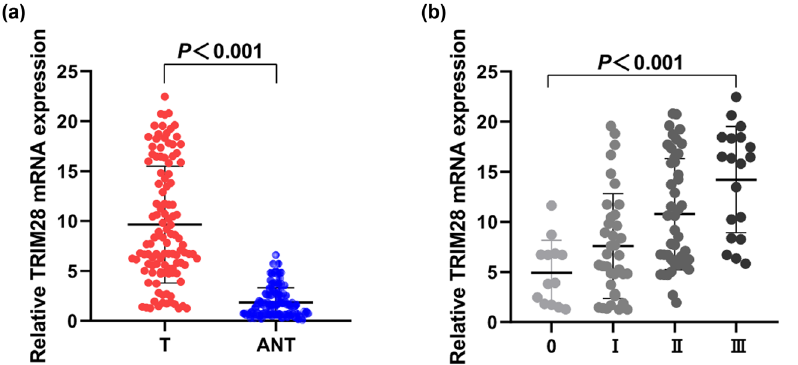
Figure 1: The analysis of TRIM28 expression by PCR. ( a ) TRIM28 expression in BC tissues was signi fi cantly higher than that in adjacent normal tissues ( P < 0.001 ) . ( b ) TRIM28 expression in di ff erent TNM stages ( P < 0.001 ) . ANT, adjacent normal tissue; T,